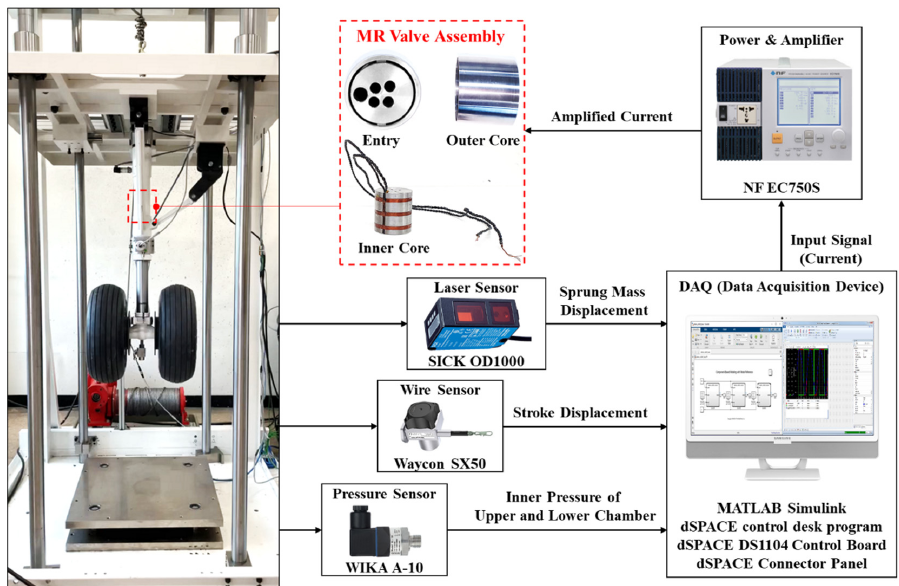
Figure 6. Vertical drop test device for performance evaluation of MR shock absorber.